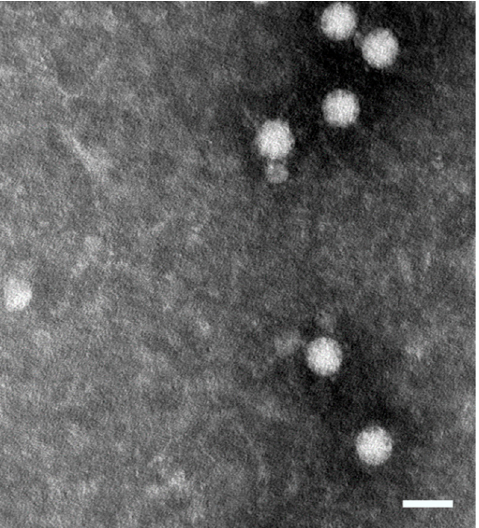
Figure 1. Electron microscopy (EM) graph of mink astrovirus (MAstV), Danish strain DK7627 used for challenge experiment of litters. To prepare the infectious material for the experiment, fecal samples of a naturally-infected mink were examined by EM and small star-like particles of MAstV, 30 nm in diameter, were observed. Further analyses with a MAstV-specific PCR and sequencing also detected the genome of the MAstV Danish strain DK7627 in the sample. The number of RNA copies of MAstV in this infectious material measured by a quantitative PCR was 10 7 /mL. This was later used for the challenge of litters. The white bar scale is 50 nm. The EM examination was performed at the Swedish Institute for Infectious Disease Control (SMI).